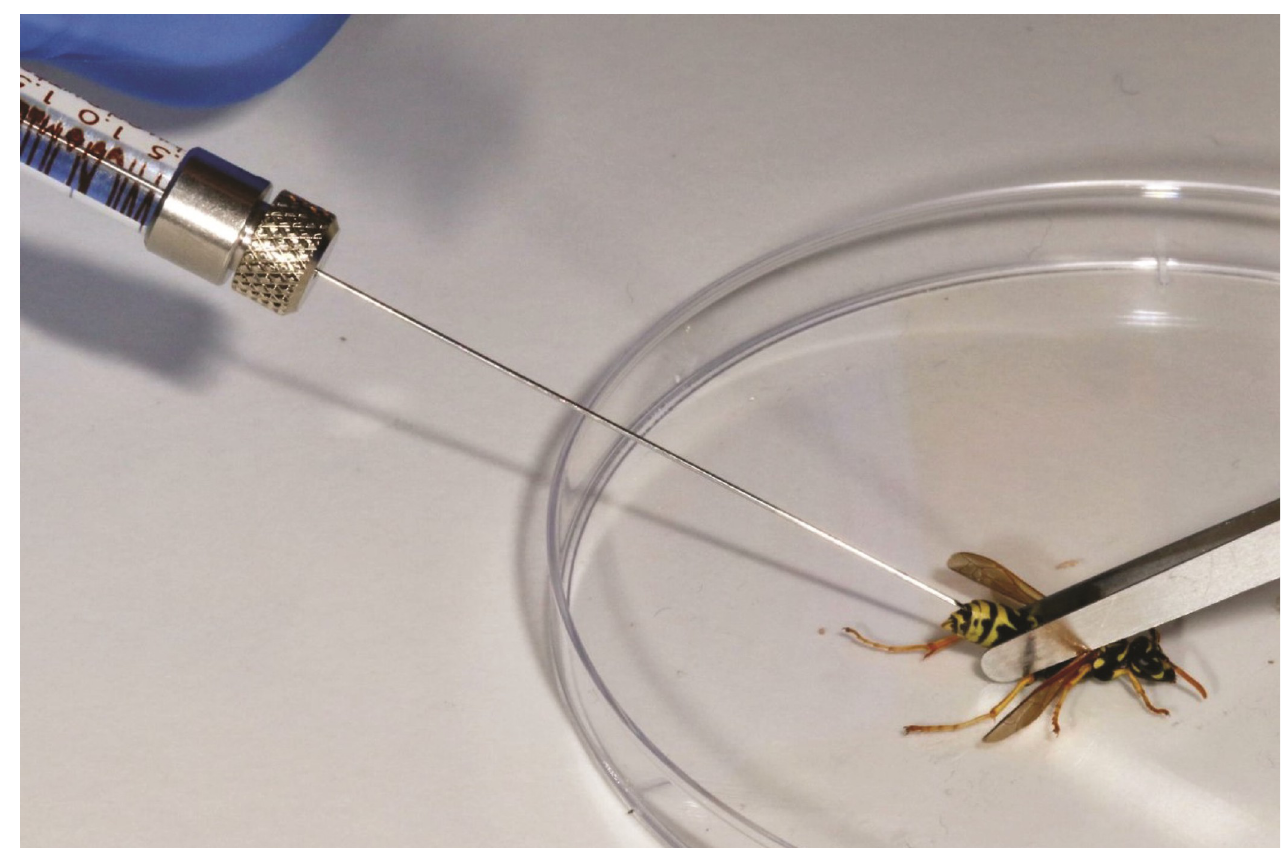
Fig 1. A photograph showing how the dsRNA injections were delivered into the paper wasp’s abdomen. Photograph credit: Phil